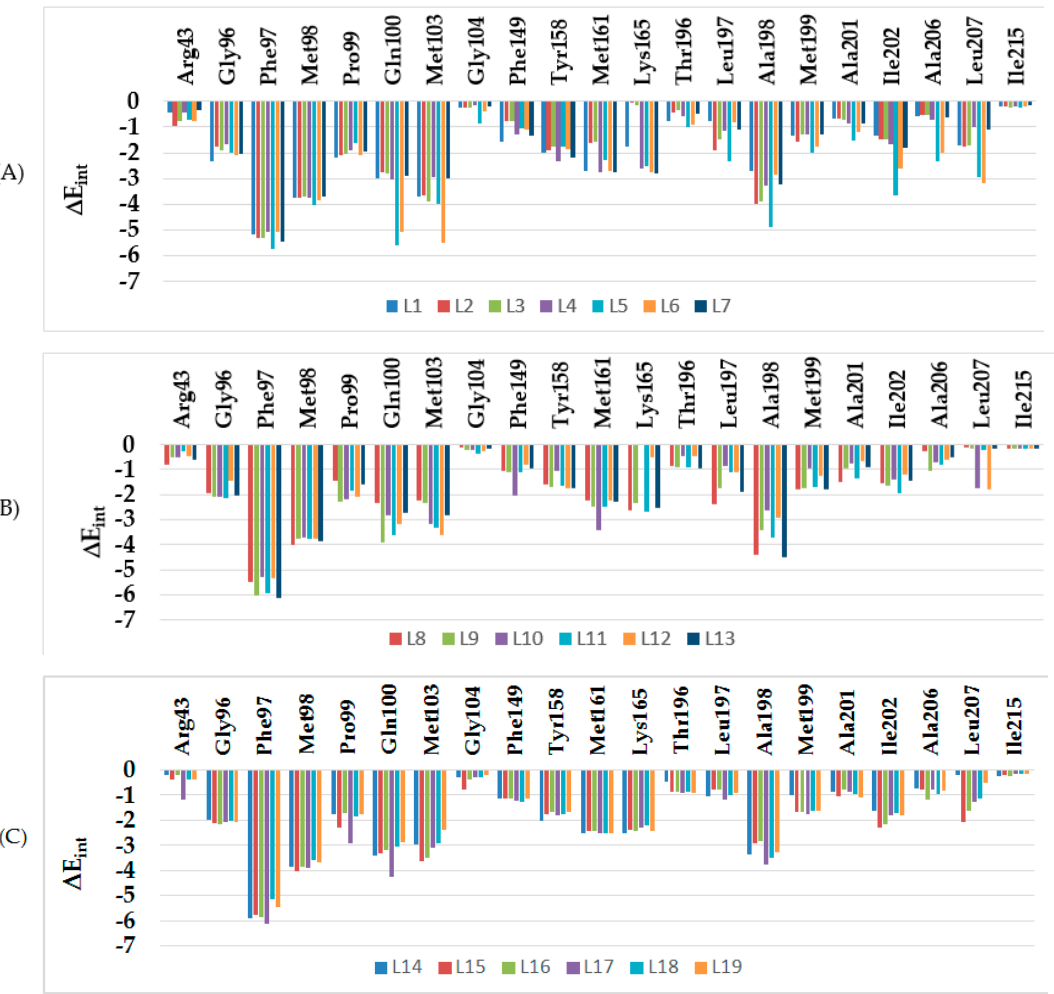
int breakdown to residue contributions